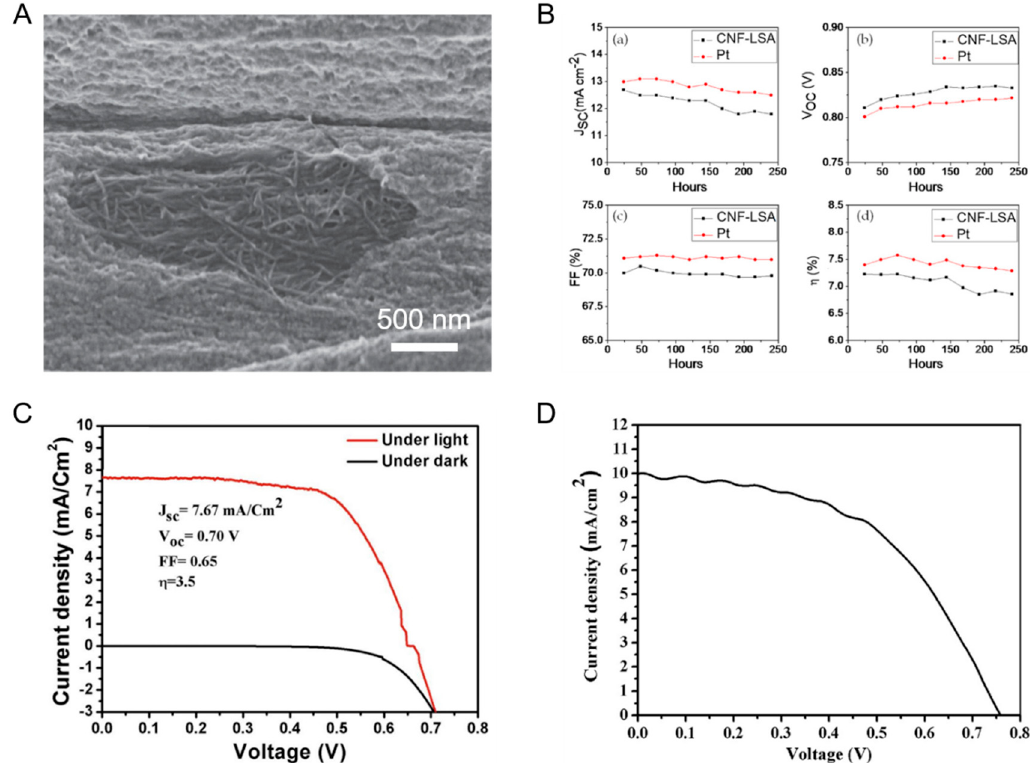
Figure 4. ( A ) SEM image of the core-sheath nanostructured fiber. Reproduced with permission from [37]. ( B ) Photovoltaic output characteristics ((a) short-circuit current density, J SC , (b) open-circuit voltage, V OC , (c) fill-factor, FF, (d) energy conversion e ffi ciency, µ ) for CNF-LSA and Pt counter electrode (CE)-based dye-sensitized solar cells (DSSC)s. Reproduced with permission from [38]. ( C ) V-I performance and cyclic voltammetery curves for NiCu-CNF composite CE-based DSSC. Reproduced with permission from [39]. ( D ) V-I performance curve of the Co-TiC CNF CE-based DSSC. Reproduced from [40].